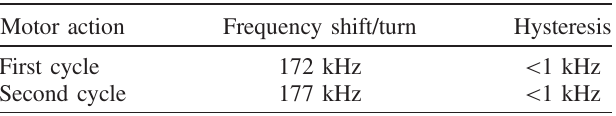
TABLE I. Tuner operation at warm. Each test cycle consists of a full motor spindle turn followed by the return to the initial position.